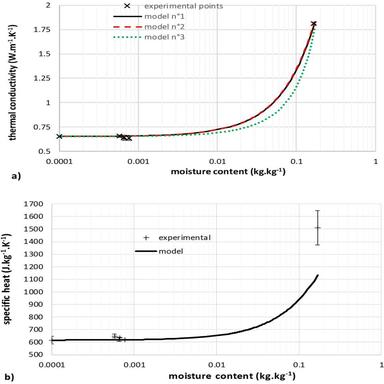
Evolution of the thermal conductivity a) and of the specific heat b) in function of moisture content – In order to be represented in these graphs, the thermal conductivity and specific heat at dry state are plotted for u = 0.0001 kg.kg1 - The coefficient b in model n1 based on Eq. is estimated at 10.6 from the least square method.